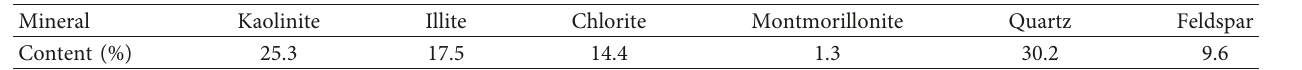
Table 2: Mineral composition.